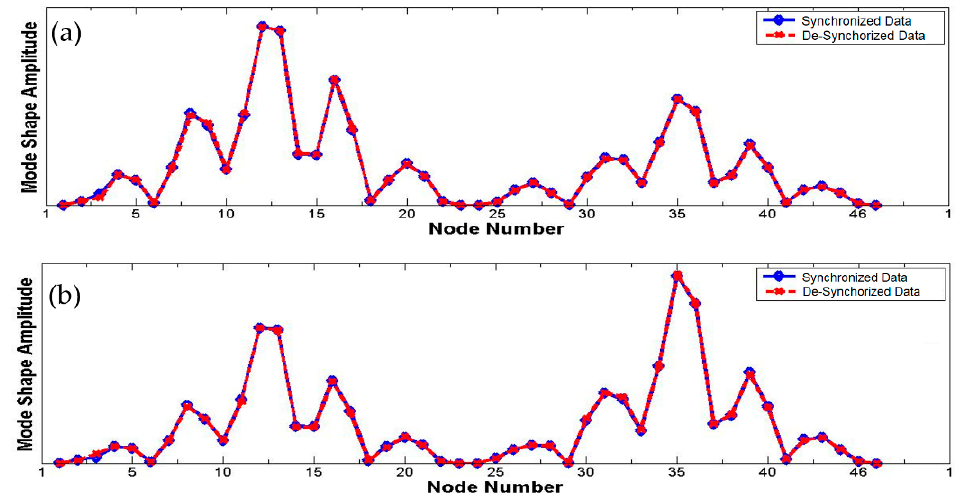
Figure 5. Mode shape amplitudes at each node—first mode ( a ) and second mode ( b ).